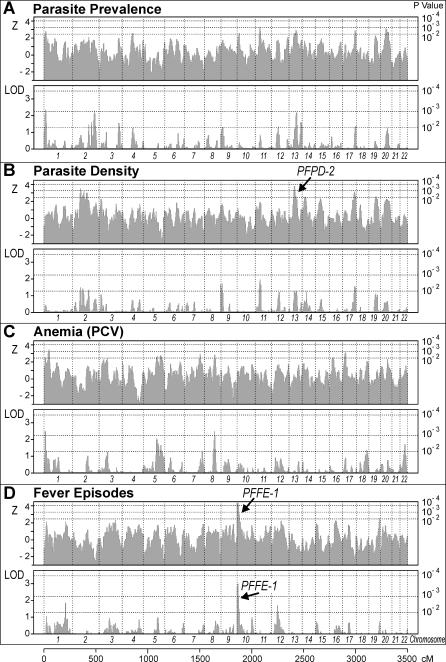
Quantitative-Trait, Multipoint Linkage Analysis of the Key Phenotypes of Uncomplicated Human Malaria(A and B) Parasitological phenotypes. (C and D) Clinical phenotypes. A 10k-Affymetrix SNP array was used for genotyping 377 individuals comprising 241 siblings of 68 families. Results obtained by NPL are presented in the upper panels (z scores [Z] on the left axis) and those of HE are presented in the lower panels (LOD scores [LOD] on the left axis). Empirical significance levels (p-values indicated by dotted lines) were estimated by 100,000-fold Monte-Carlo permutations.